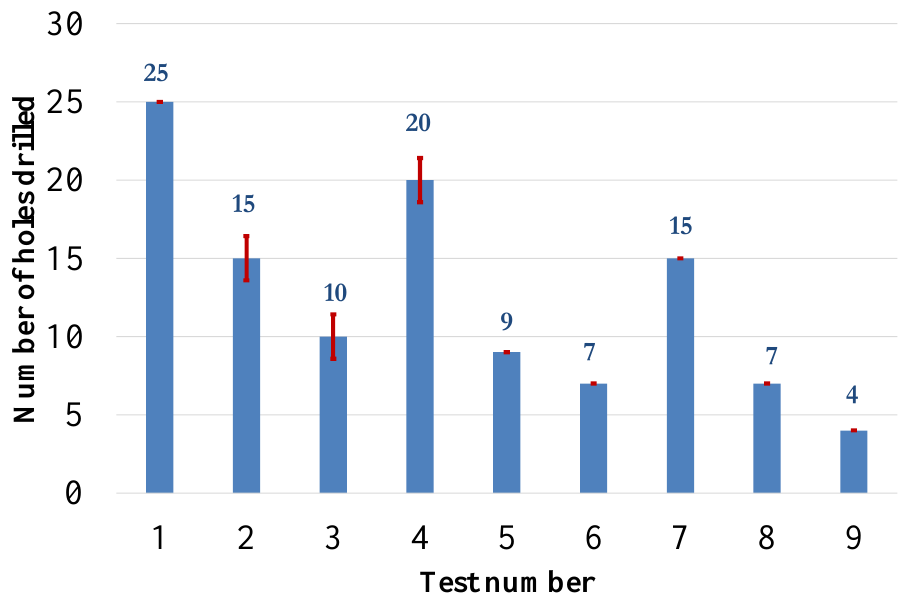
Figure 10. Tool life with respect to number of holes.